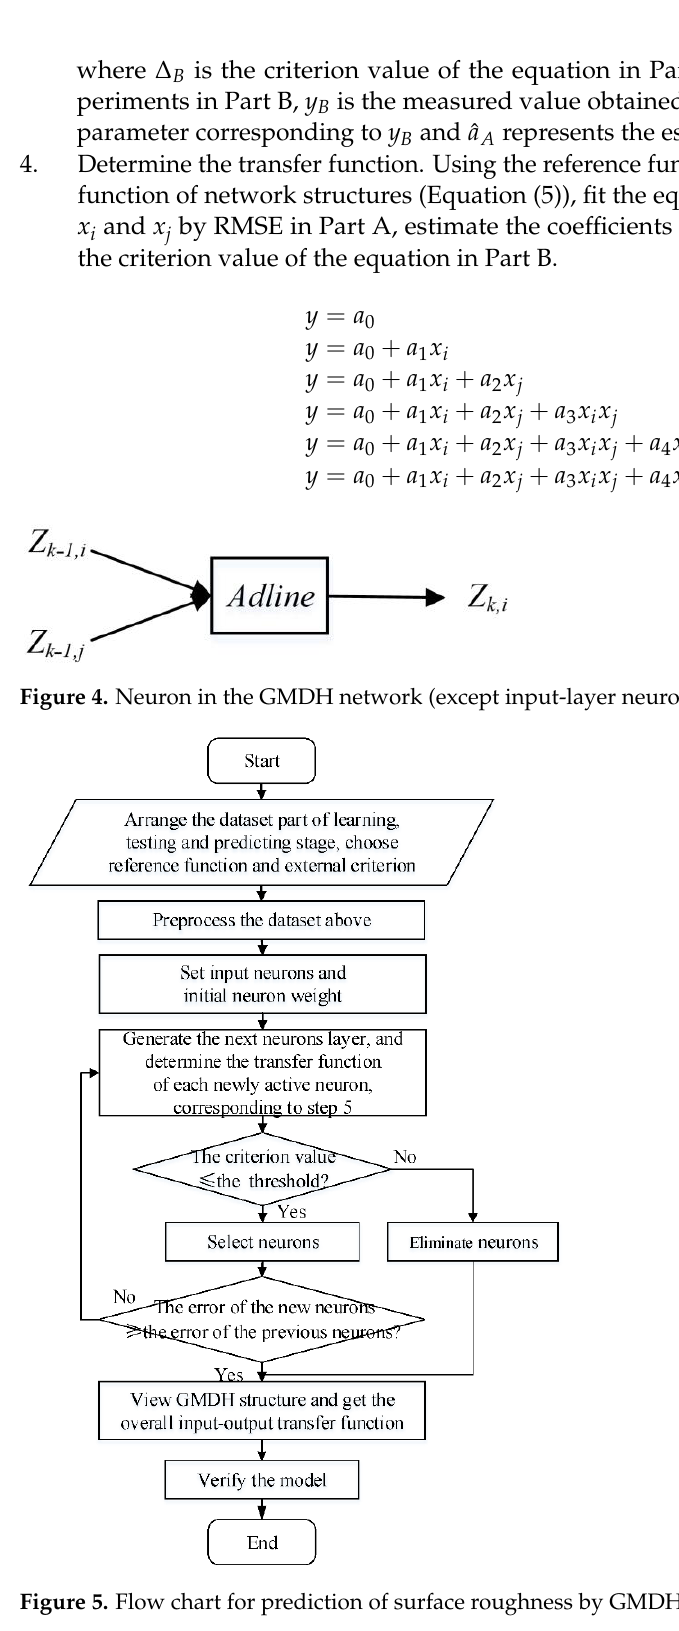
Table 3. Experimental results of micro-milling LF21. Group